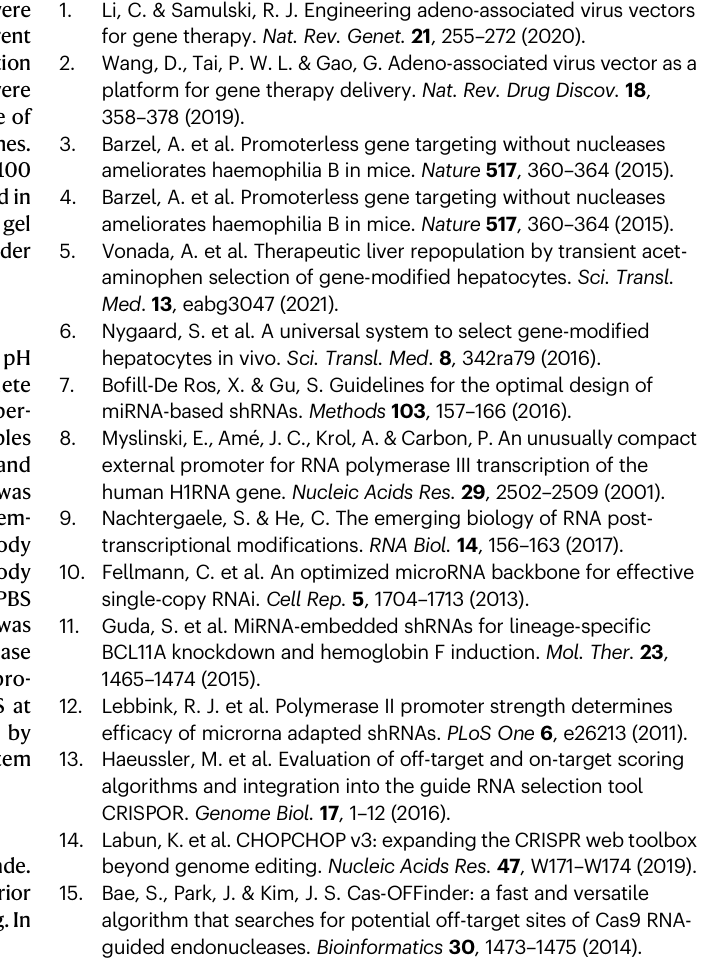
(Thermo Fisher Scienti fi c) with a Gene Ruler 1 kb plus DNA ladder (Thermo Fisher Scienti fi c) for visualization. Western Blot Liver samples were homogenized in HEN buffer (10 mM HEPES